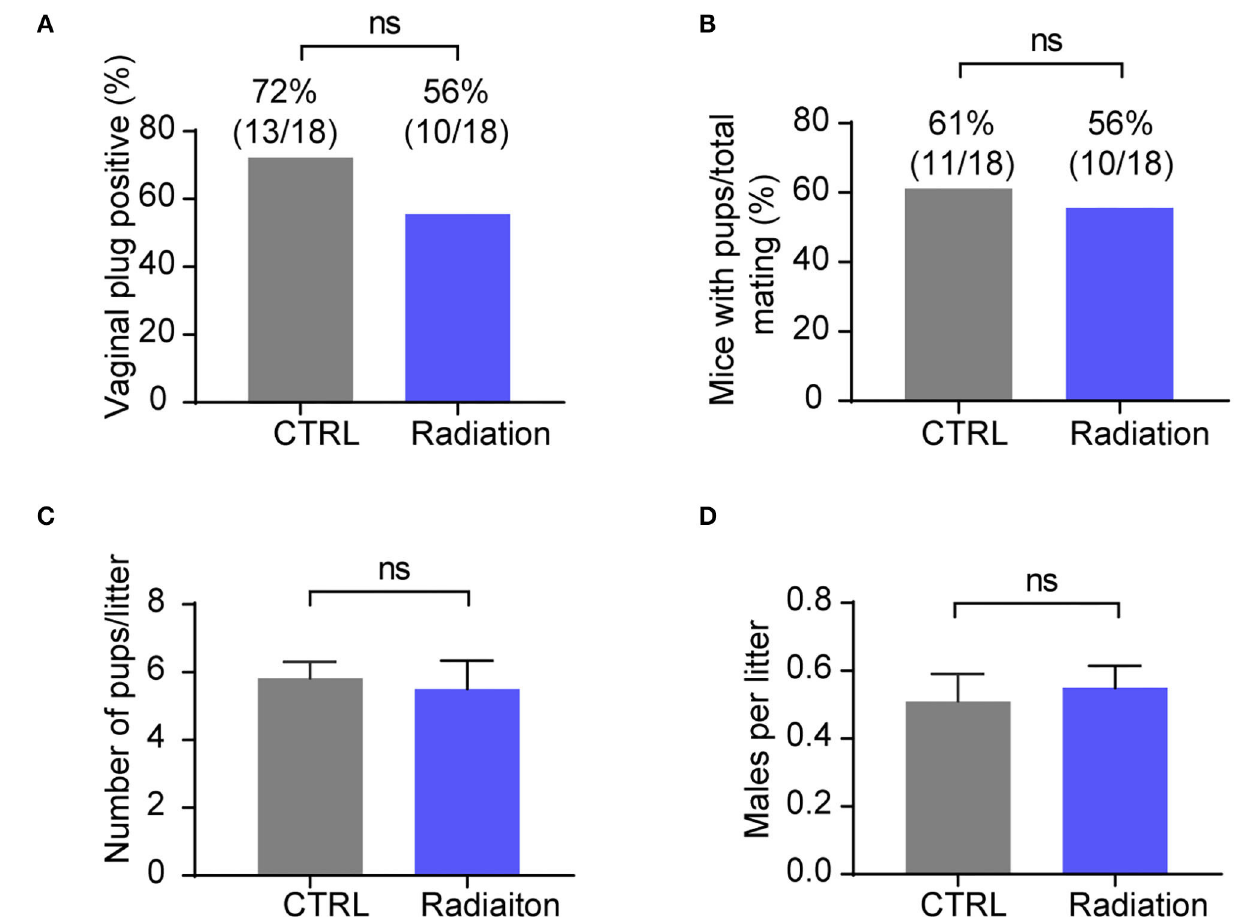
FIGURE 4 | RF-EMR exposure does not influence male mice fertility. (A,B) Male fertility reflected by female mice pregnancy rate. Chi-square test. (C) Average litter sizes of CTRL or Radiation mice offspring. (D) Sex ratio of pups from CTRL or Radiation mice. (A–D) CTRL, mice in sham group; Radiation, mice in RF-EMR exposure group. ns, not significant. (C,D) n = 8–11. A two-tailed Student’s t -test was performed.